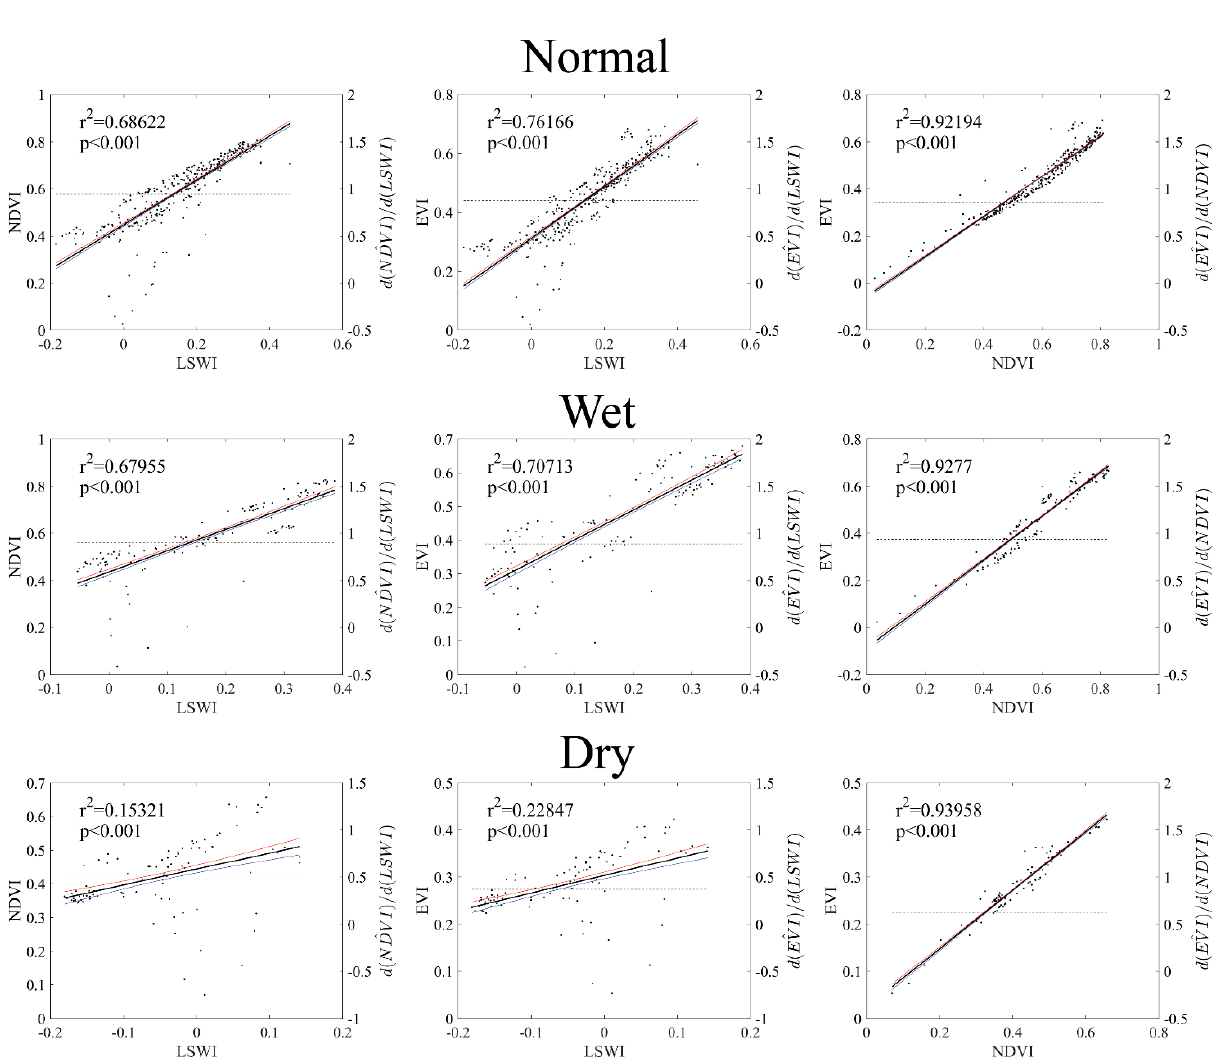
Figure 4. Correlation charts between vegetation index values and unique climate conditions (normal, wet, and dry). NDVI: normalized difference vegetation index; EVI: enhanced vegetation index; and LSWI: land surface water index.